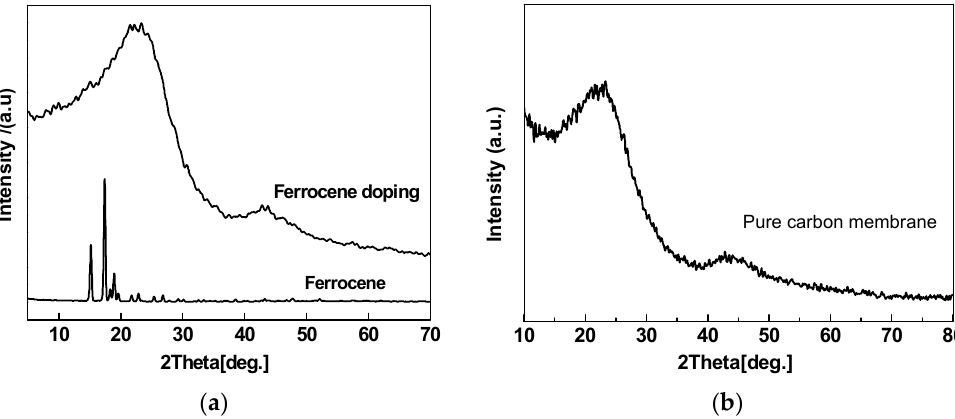
Figure 4. XRD patterns of ferrocene/PAA-based Fe/C hybrid membrane ( a ) and PAA-based pure CMS membrane ( b ) [63].